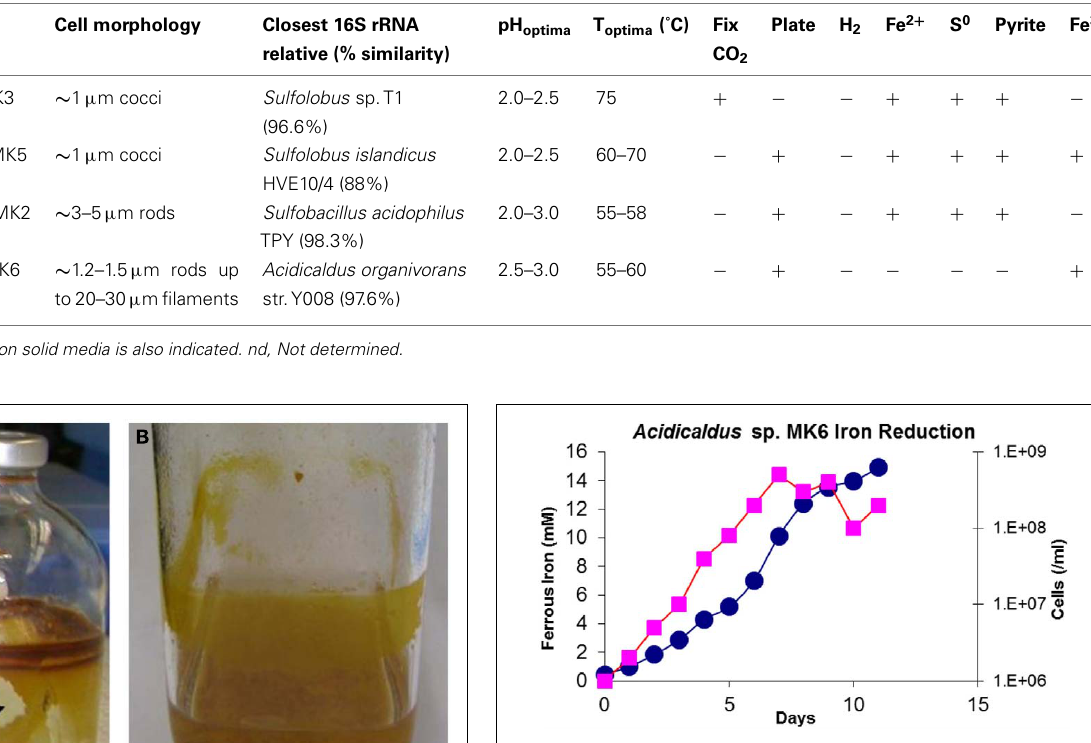
FIGURE 10 | Concentration of ferrous iron (mM) and cell counts (cells/mL) plotted as a function of time in anaerobic serum bottle cultures with Acidicaldus sp. strainMK6. Cultures were maintained at pH 3.0 with 10mM glucose and 0.5g autoclaved Fe-oxide mat from NGB-BED. Squares = cells/mL; circles =